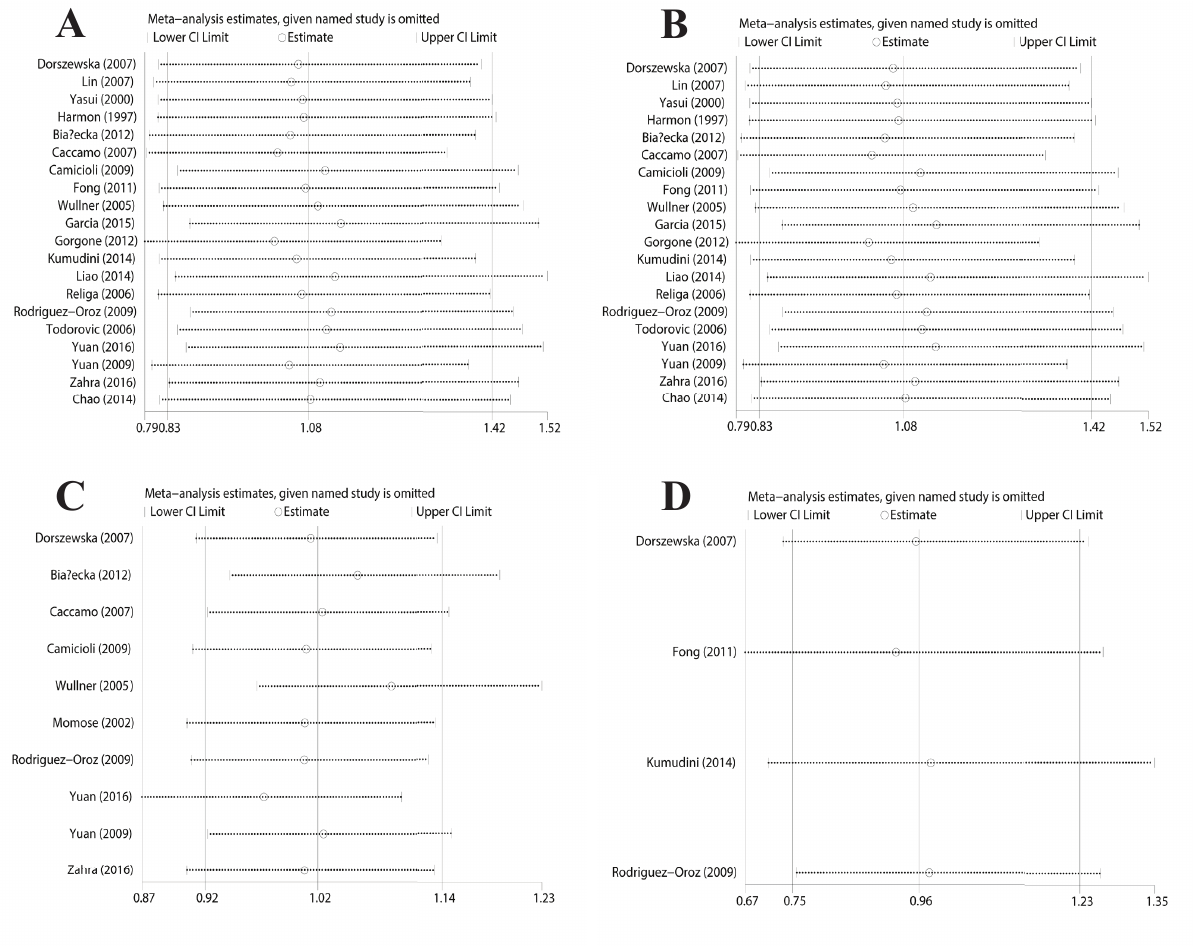
Figure 5: Sensitivity analysis of studies on MTHFR genetic polymorphism and PD: (A) allelic and (B) co-dominant genetic model for C677T polymorphism; (C) allelic genetic model for A1298C polymorphism; (D) allelic genetic model for A2756G